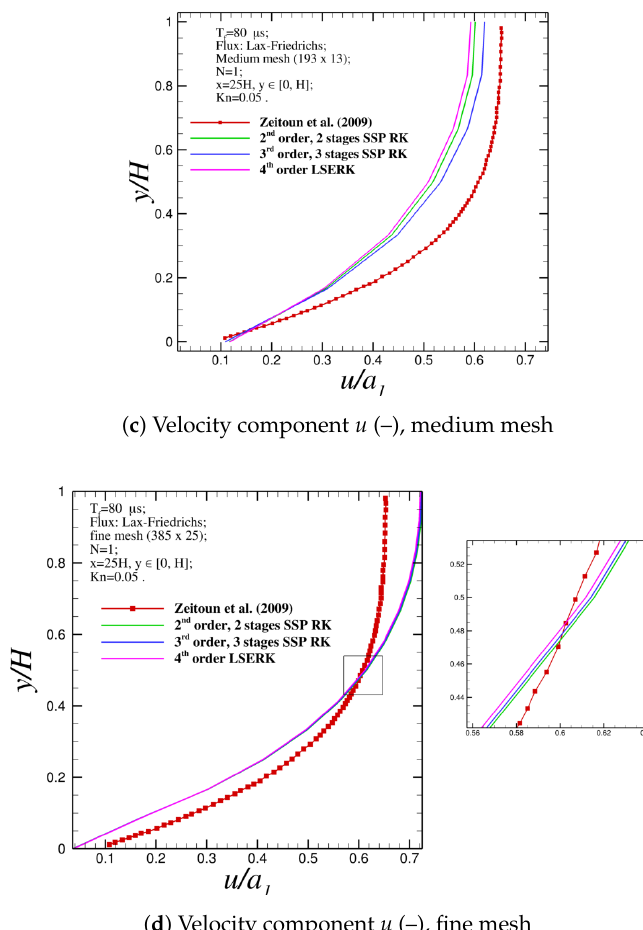
Figure 7. Dimensionless density profile in the centerline of the microchannel ( a , b ); and streamwise velocity u in the cross section x = 25 H ( c , d ) using the: medium ( a , c ); and fine ( b , d ) mesh at the final time T f = 80 µ s with Kn = 0.05 and N = 1. Comparison between different explicit Runge–Kutta schemes: second-order, two-stage SSP–RK, third-order, three-stage SSP–RK, and fourth-order LSERK. Validation with reference data of Zeitoun et al.